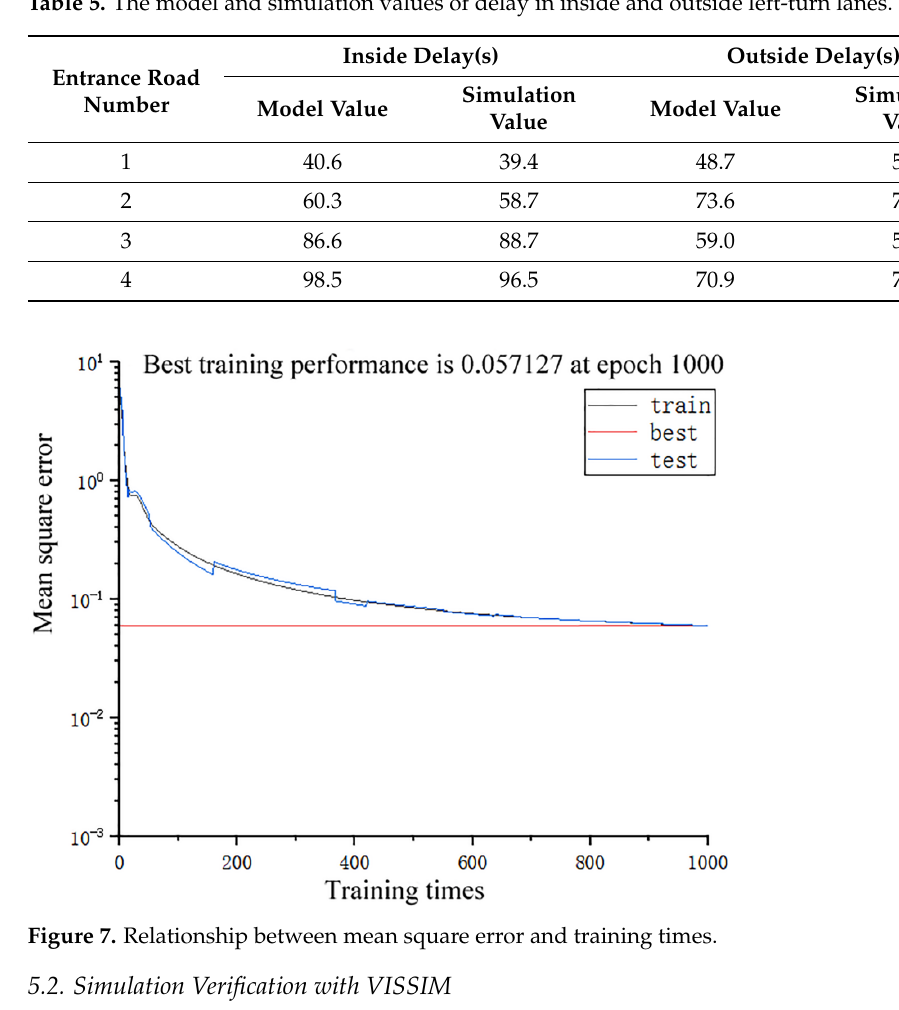
Table 5. The model and simulation values of delay in inside and outside left-turn lanes.